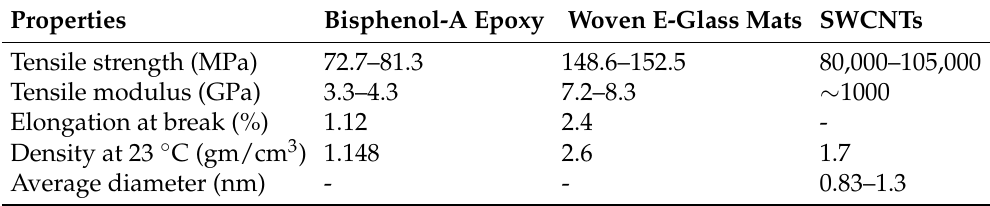
Table 1. Properties of materials used—data collected from the suppliers.